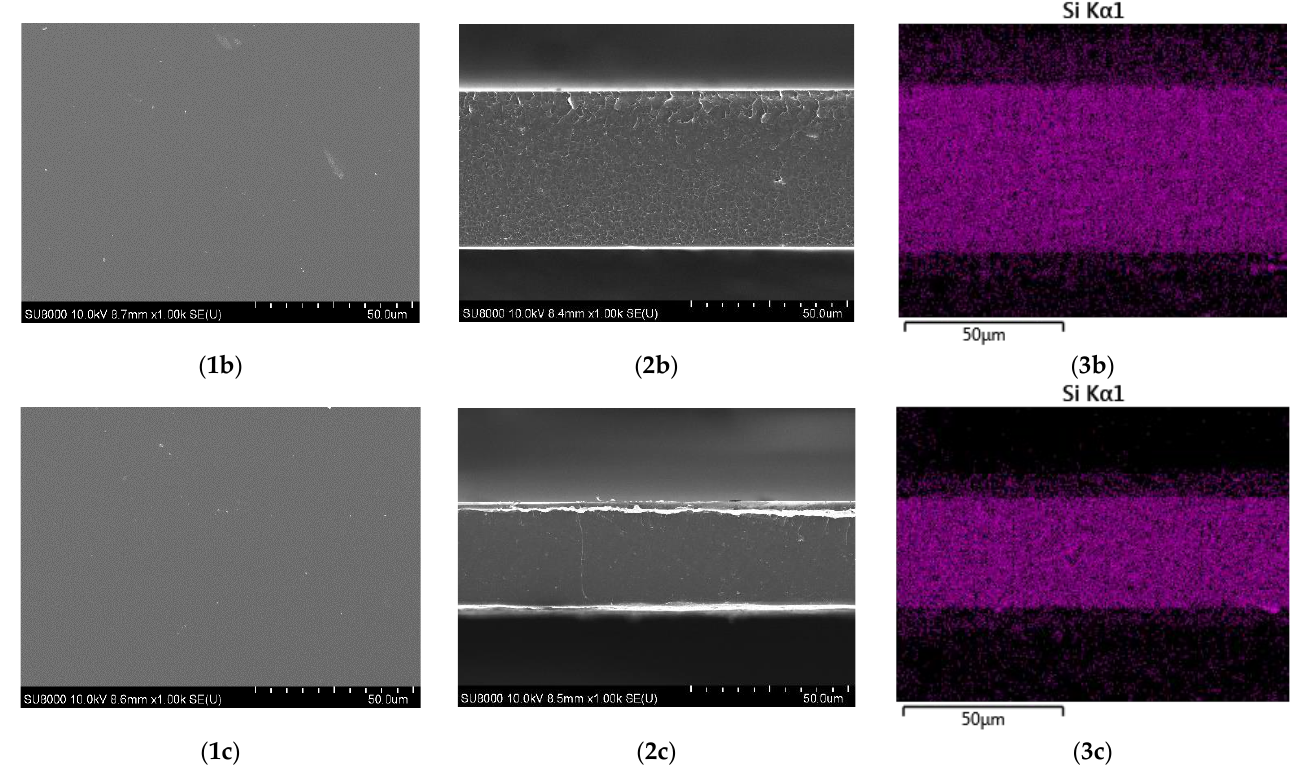
Figure 3. SEM images of the surface ( 1 ); cross-section ( 2 ) and Si mapping ( 3 ) of PBI/SiBr-0.5 ( a ); PBI/SibiC-0.5 ( b ) and PBI/KH 560-0.5 ( c ).